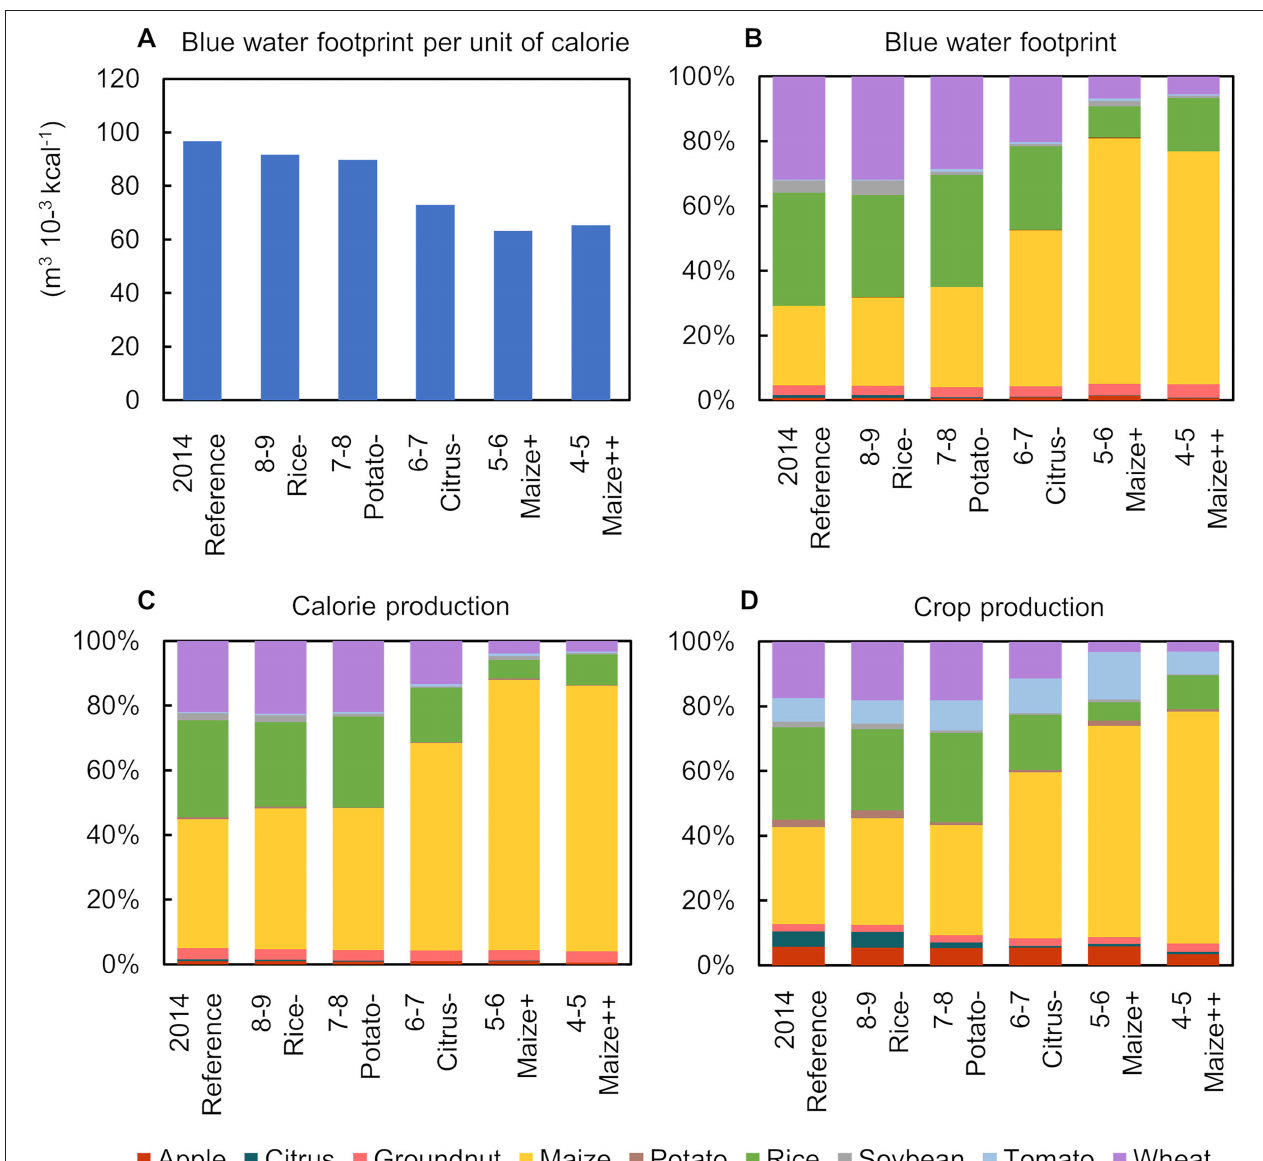
FIGURE 6 | Characteristics of different crop production allocations. The BWF per unit of calorie production in different crop production allocations (A) , relative contribution of crops to the BWF of crop production (B) , calorie production (C) , and crop production (D) under different crop production allocations (the legend below is for B–D